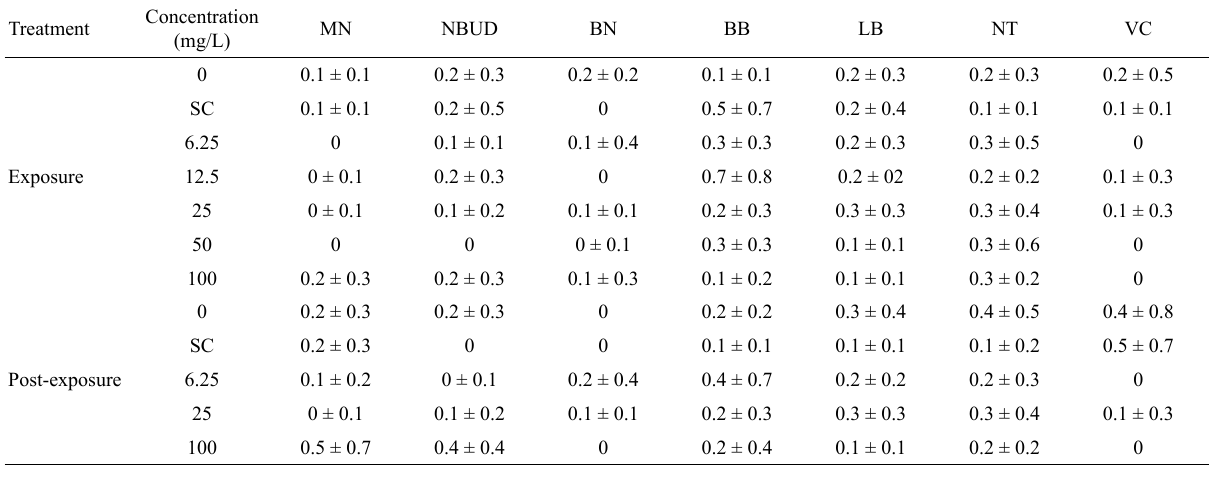
Table 1 – MN – micronucleus, NBUD – nuclear bud, BN – bilobed nucleus, BB – blebbed, LB – lobed, NT - notched, CV - cell vacuoles. In the case of both the exposures and post-exposures, no genotoxicity was found compared with controls (P > 0.05). Treatment